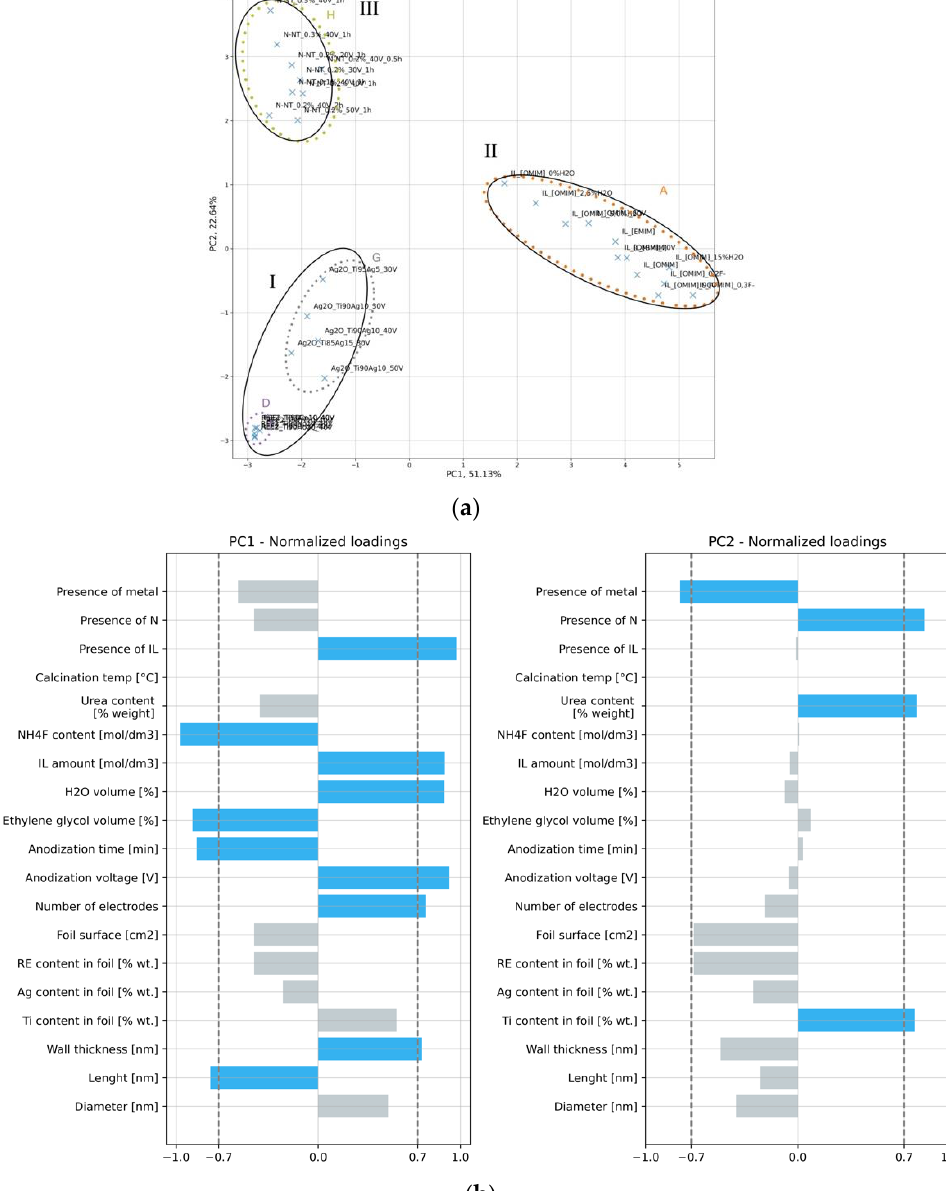
Figure 2. ( a ) Score plots from the two PC analyses performed for 32 well-ordered TiO 2 -based NTs in the space of descriptors that represent the experimental conditions and structural features of TiO 2 -based NTs; ( b ) Correlation coefficients between a selected descriptor and either PC1 or PC2 (loadings values). Color codes: Values marked in blue are significant in particular PCs and determine the physical interpretation of these PCs.